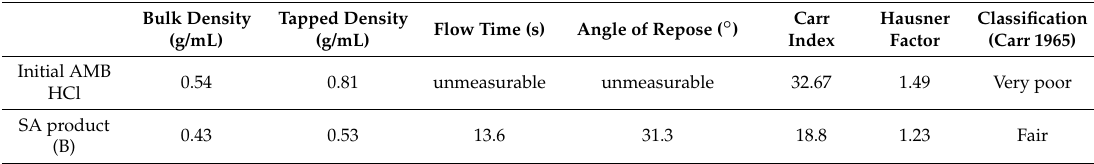
Table 7. Improvements in the powder rheological properties comparing the initial material and the SA (B) product.